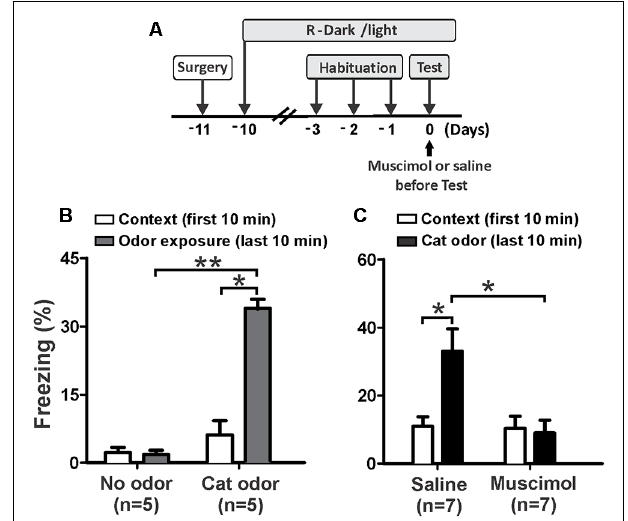
FIGURE 2 | Inactivation of the pIC prior to the first exposure to cat odor abolished the innate freezing expression. (A) Timeline of the experimental design. (B) Rats were first exposed to a familiar control collar (Context) for 10 min and were then exposed either to a collar with or without cat odor for an additional period of 10 min (odor exposure). The bars show the percentage of time spent freezing displayed by non-implanted rats. (C) Percentage of time spent freezing displayed by implanted rats that received saline or muscimol into the pIC 30 min before testing and were exposed to cat